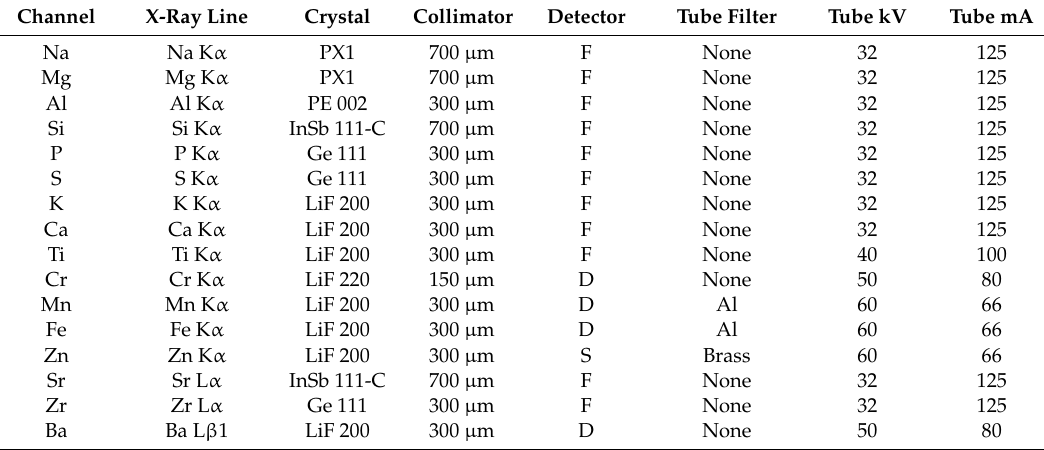
Table 3. Operational conditions for the XRF OXI program. Rh-anode X-ray tube used for these scans. Al tube filter is 200 µ m thick; brass tube filter is 100 µ m thick. F = flow detector; D = duplex detector; S = scintillator detector. The flow detector uses an Ar-CH 4 gas mixture.